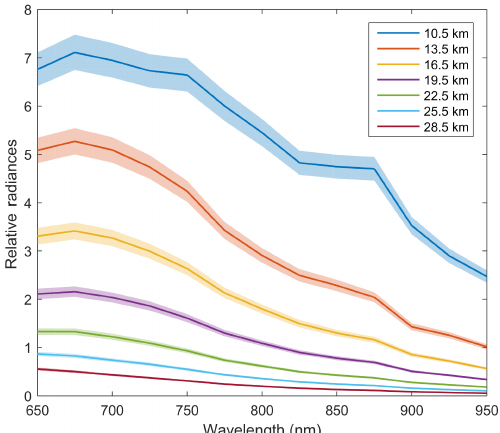
Figure 11. Level 1 relative radiances spectrally from 650 to 950nm as measured from ALI at approximately 14:20UTC, consisting of images 204 to 216 looking 90 ◦ in the azimuth from the sun facing southwards. These spectral profiles are presented at several tangent altitudes with a horizontal look direction of 0 ◦ . The shading repre- sents the error on the